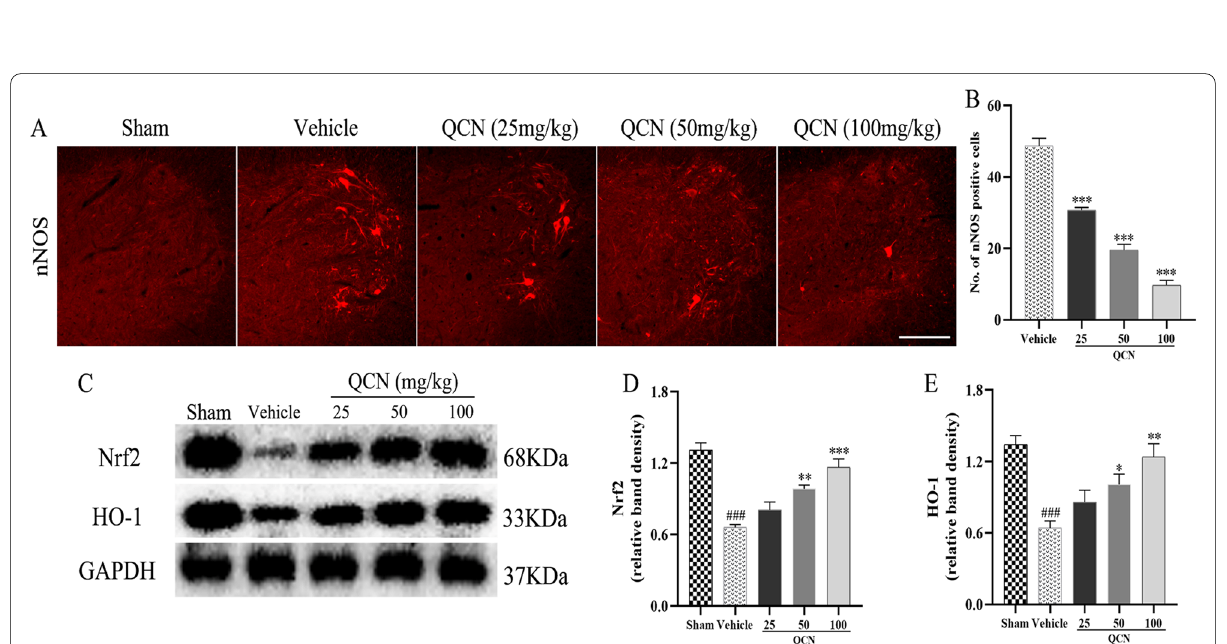
Fig. 6 Effects of QCN on oxidative stress of the BPA rats at week 2 post‑avulsion . A Representative images of nNOS staining cells in the ipsilateral C6–7 ventral spinal segments at 2 weeks post‑avulsion injury. B Quantification of nNOS staining cells of each group. (Scale bar 200 μm. n protein levels of Nrf2 and HO‑1 as determined by western blot. Quantification of D Nrf2 and E HO‑1 protein in the ventral horn of the C6–7 spinal segments. Data are expressed as the mean SEM ( n 3). ### p < 0.001 vs the sham group; * p < 0.05, ** p < 0.01, and *** p < 0.001 vs the vehicle ± =